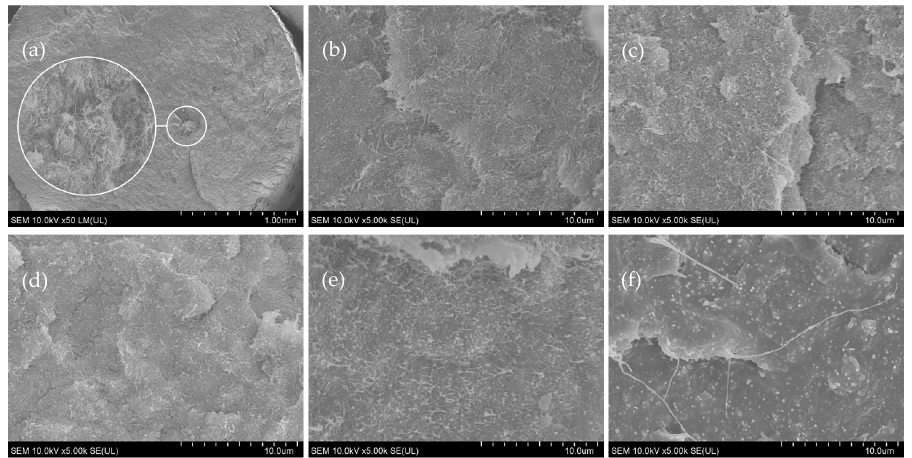
Figure 3. SEM images of PLA/MWCNT composite samples: ( a ) PLA/CNT/Sx1 (with MWCNT agglomerate), ( b ) PLA/CNT/Sx2, ( c ) PLA/CNT/Sx3, ( d ) PLA/CNT/Tx1, ( e ) PLA/CNT/Tx2, and ( f ) PLA/CNT/Tx3.